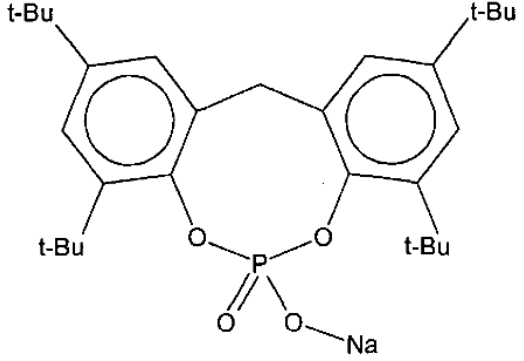
Figure 1. Chemical structure of nucleating agent NA11.